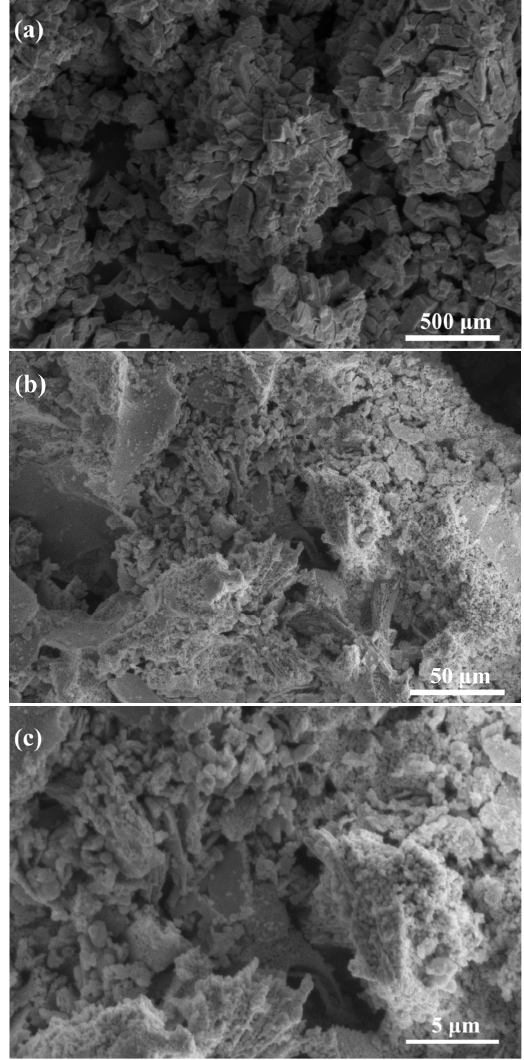
Figure 6. SEM images of LaCoO 3 /CeO 2 catalyst. ( a ). SEM of 500 μ m; ( b ). SEM of 50 μ m; ( c ). SEM of 5 μ